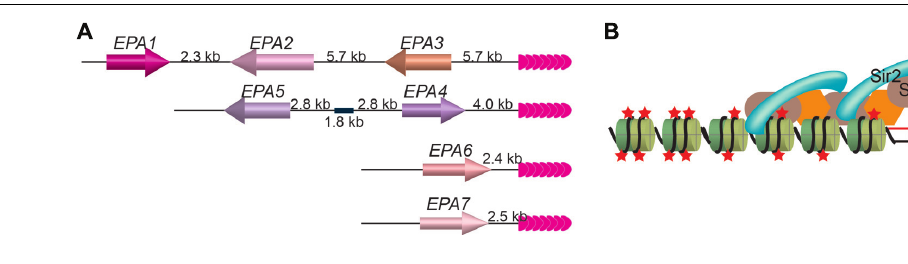
factor, while Cdc13/Stn1/Ten1 binds to single-stranded telomere DNA. Rap1 recruits Sir3 and Sir4, which in turn recruits Sir2. Sir3 and Sir4 can also interact with histones directly. Sir2’s deacetylase activity maintains the hypoacetylated state of histones. Rap1 also recruits Rif1 and Rif2. Red stars, histone acetylation groups; green cylinders,